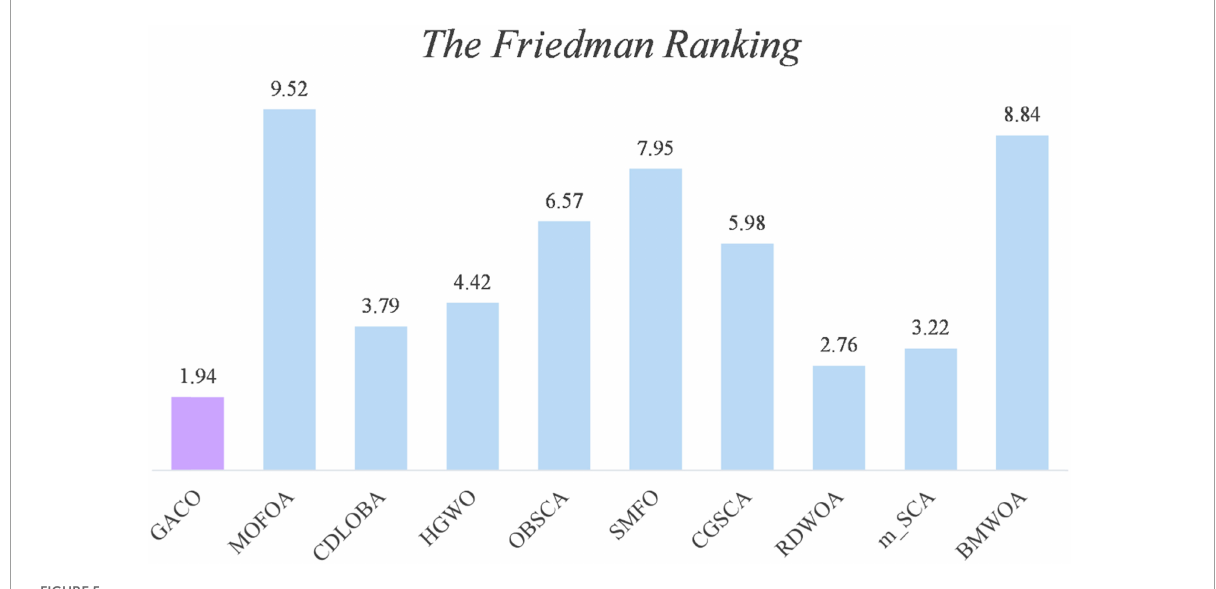
FIGURE5 The Friedman ranking results for each